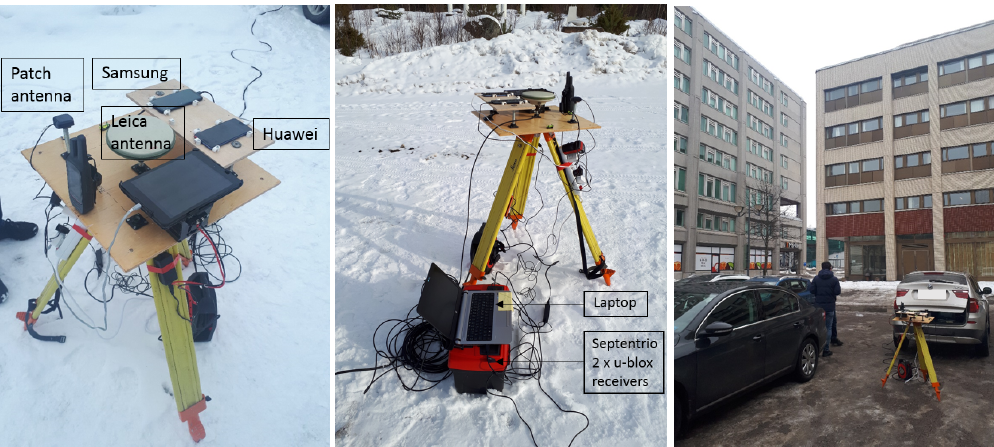
Figure 2. Images from the experimental open sky ( left and middle ) and semi-urban ( right ) test campaigns. In all campaigns, the same test equipment setup was used. The two smartphones and the antennas were fixed on a wooden